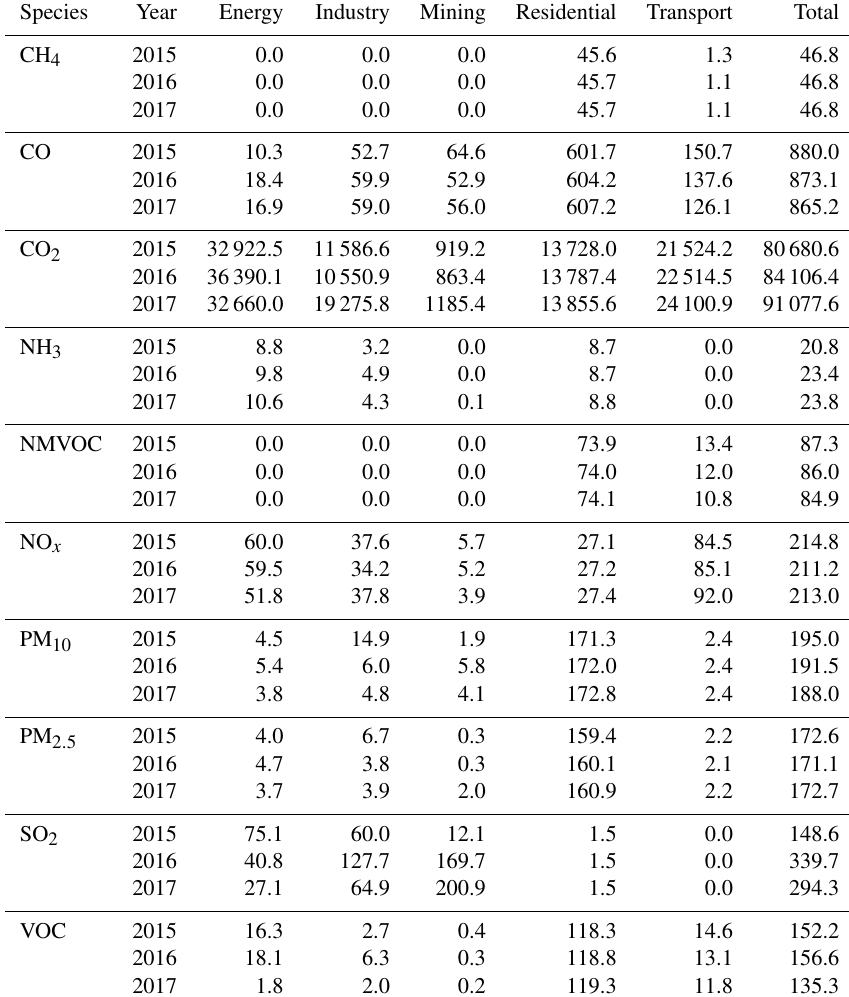
Table B1. Total emissions (kta − 1 ) by year and sector for each pollutant represented in Fig. 4. Species Energy